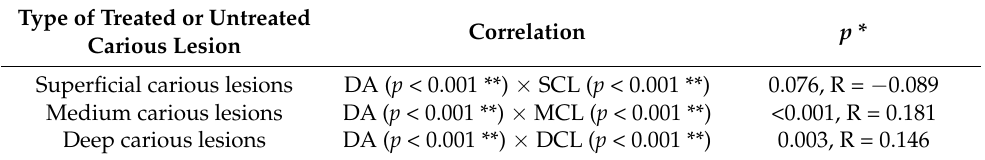
Table 4. Correlations between dental age and superficial, medium, and deep carious lesions. Type of Treated or Untreated Correlation p * Carious Lesion Superficial carious